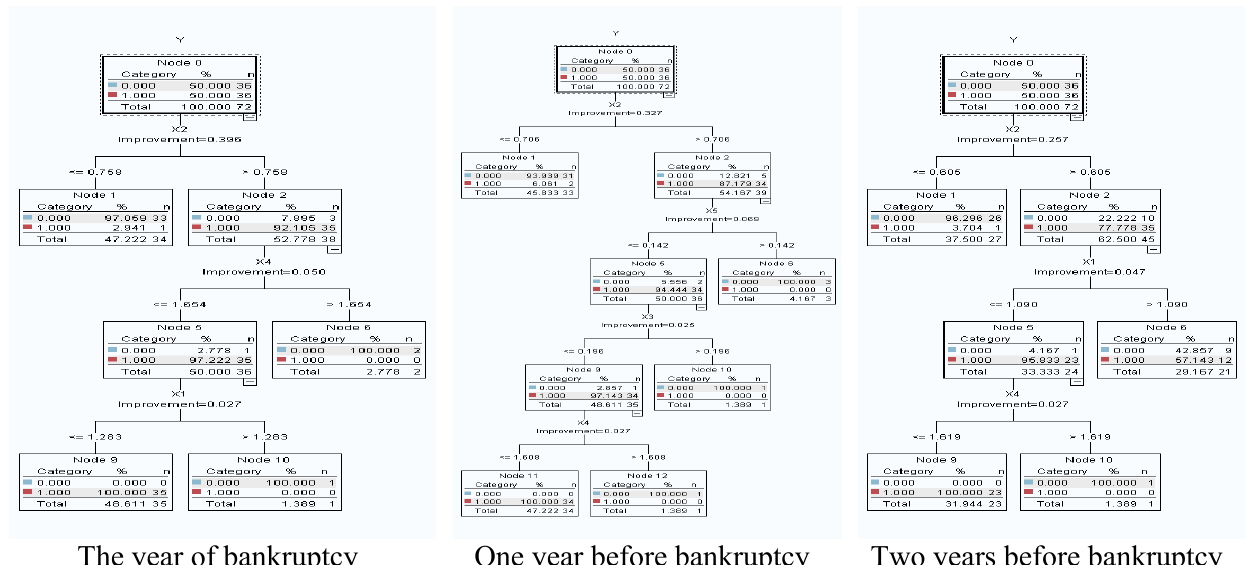
Fig. 1. Detailed results of the implementation of